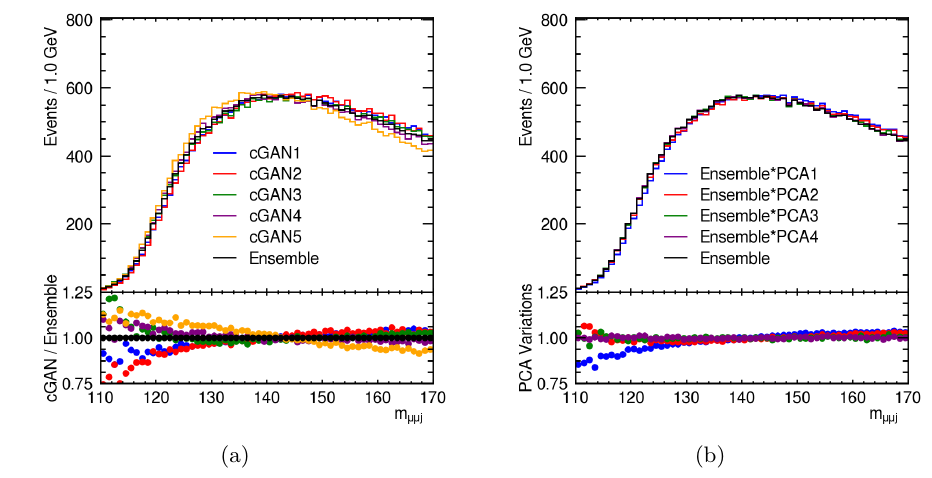
Figure 15 . (a) Variation of the top five cGANs about their ensemble, and (b) the variations that correspond to 1 σ uncertainties resulting from the principle component